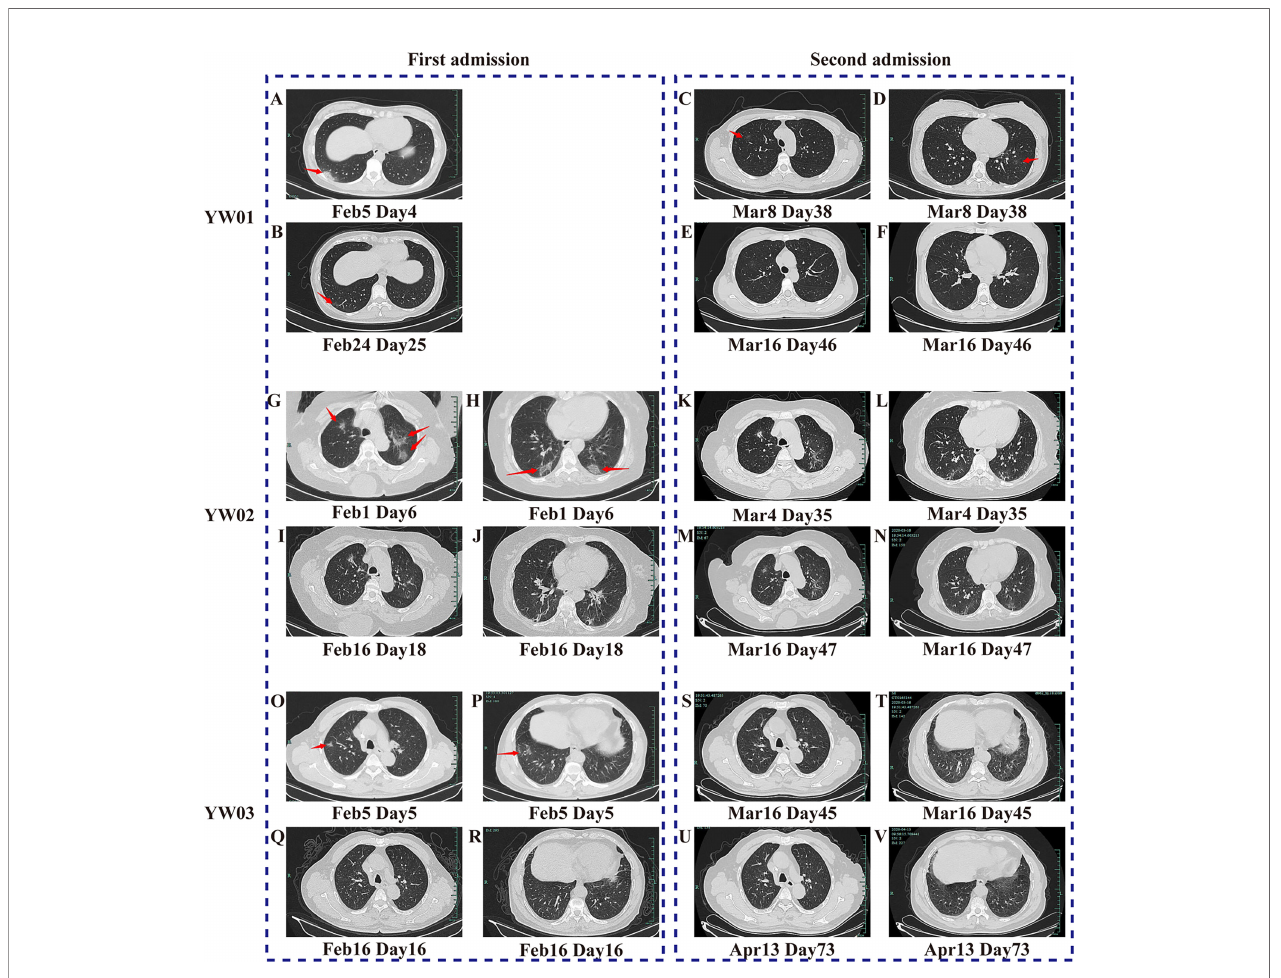
FIGURE 1 | CT scanning images of the three COVID-19 patients during two hospitalizations. The images of (A – F) belong to Patient YW01, (G – N) belong to YW02, and (O-V) belong to YW03. They showed the typical imaging changes of COVID-19 during twice episodes, from density-increased patchy consolidation and ground- glass shadow to absorption of strip high-density shadows of the lung. The red arrows in (A – D, G, H, O, P) indicate typical CT scan signs of